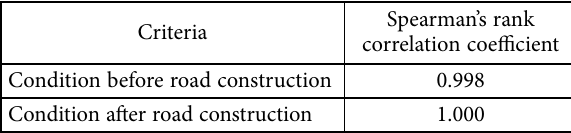
Table 13. Spearman’s rank correlation coefficients